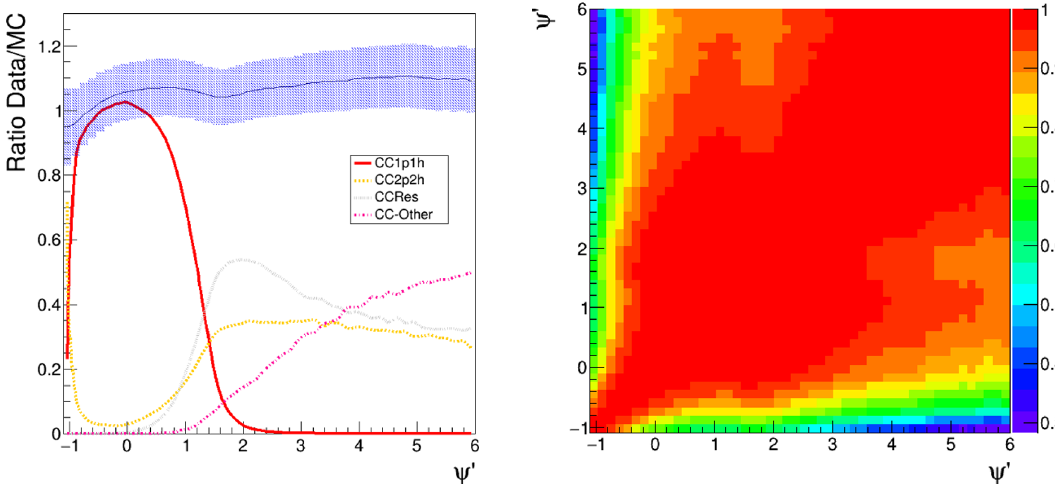
Figure 22 . The same as figure 21, but for the MINERvA CC0 π